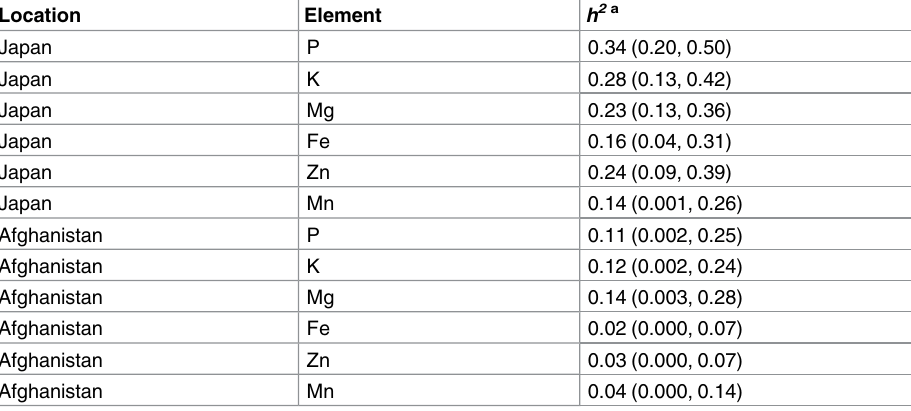
Table 1. Marker-based heritabilities of elements.